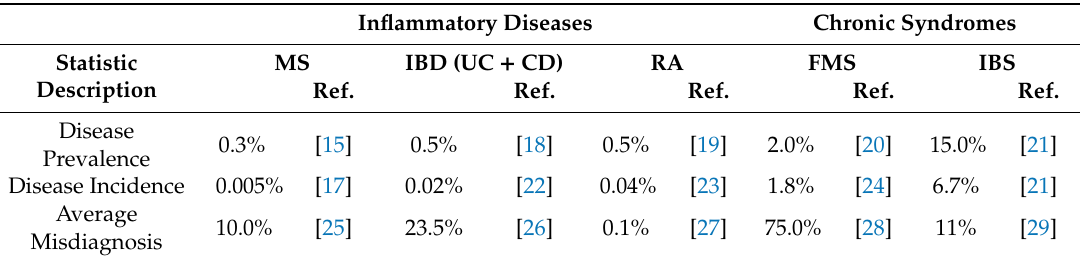
Table 1. General population statistics across indicated inflammatory diseases and